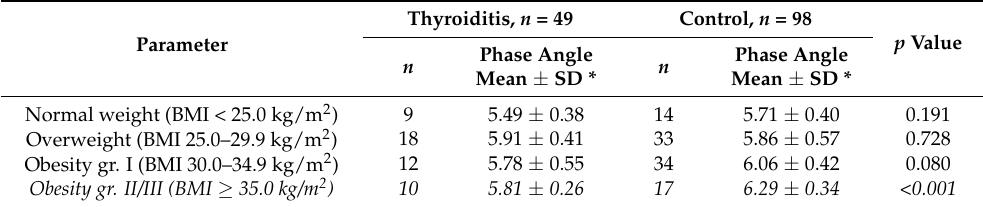
Table 3. Phase angle score in study and control groups according to BMI categories. Significant differences are emphasized in italics.